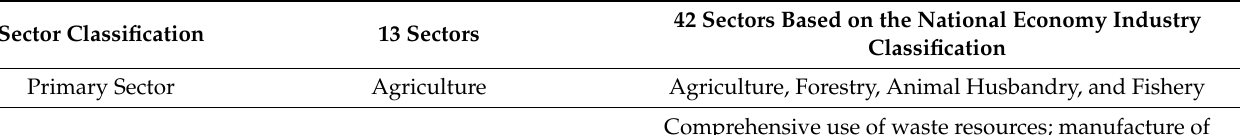
Table 1. Model sectors merged from 42 sectors national economy industry